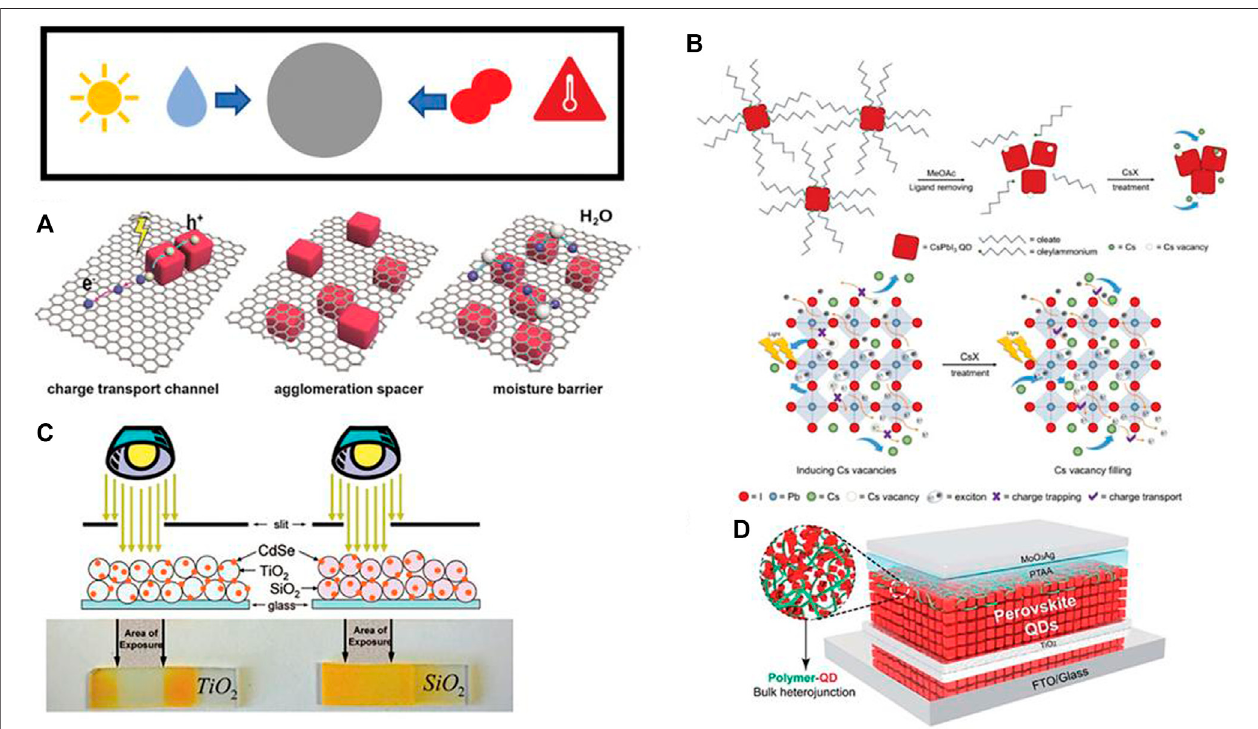
FIGURE 4 | Stress factors that impair the performance of QDs and interventions including; (A) Prevention of moisture accumulation using a thin layer of graphene, (B) the use of Ce ions for passivating the QDs, (C) QD fi lm degradation using electron transport layers using as CdSe, TiO 2 , and SiO 2 (D) Organic/polymer QD layer to protect the QDs from oxidation (Albaladejo-Siguan et al.,